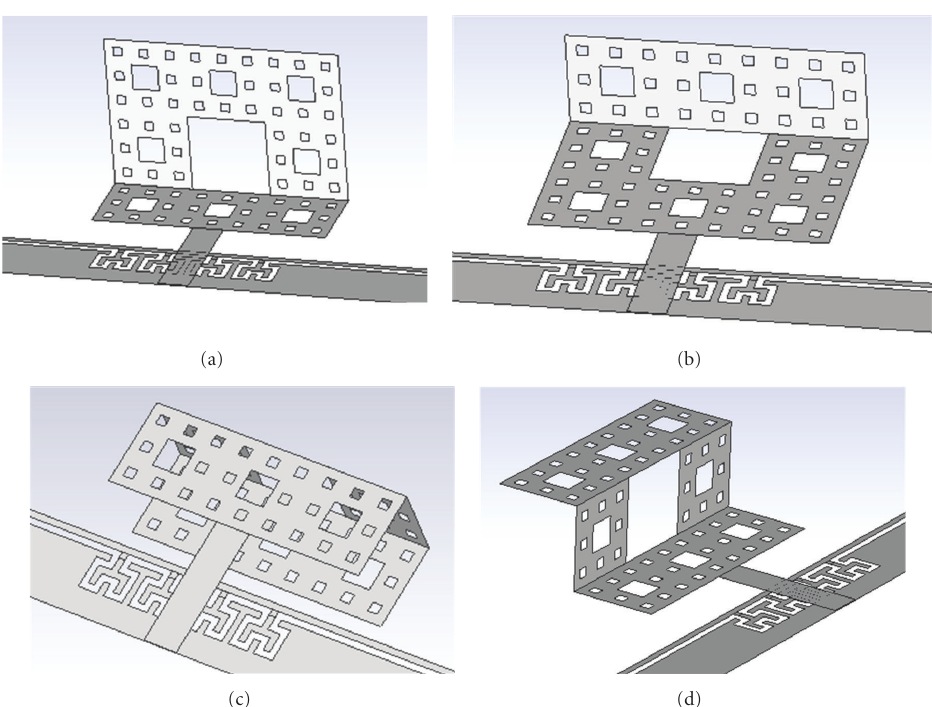
Figure 2: Di ff erent ways of folding the antenna: (a) modification 1, (b) modification 2, (c) modification 3, and (d) modification 4. it is only 2.04% for the proposed fractal antenna. The same holds for the average variation of the fractional